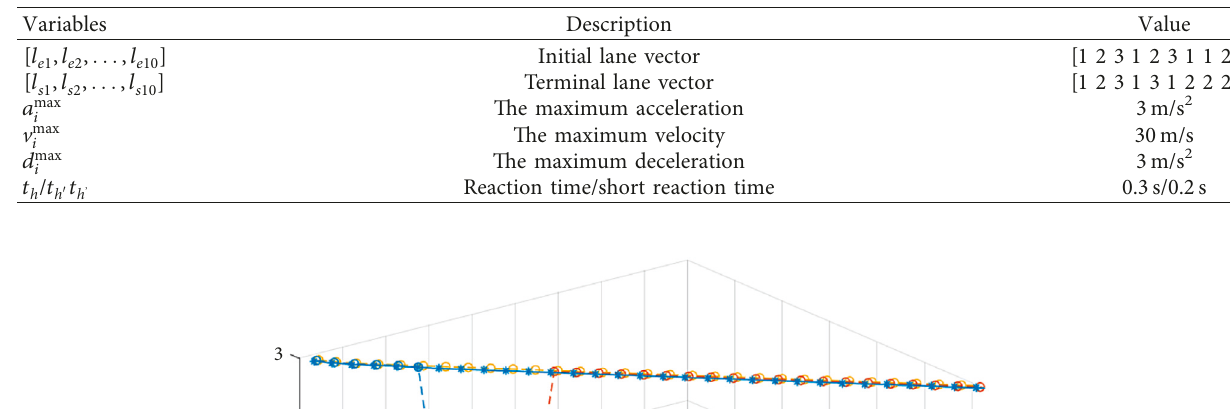
Table 3: Parameters